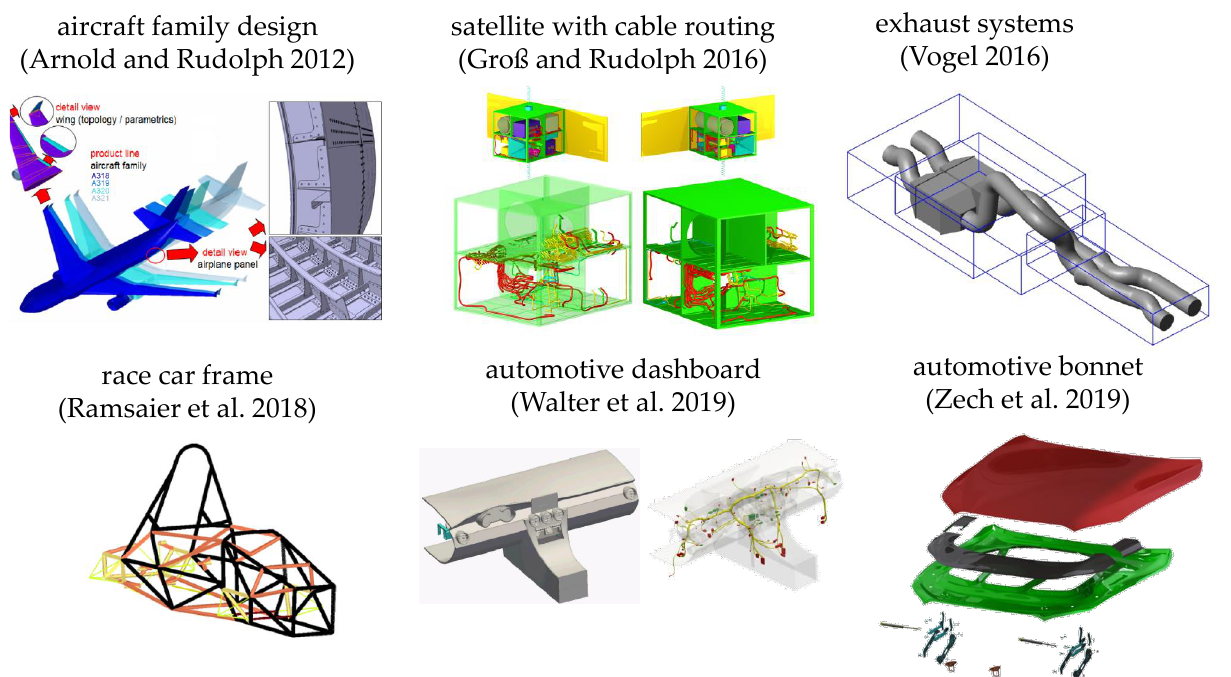
Figure 3. Successful applications of graph-based design